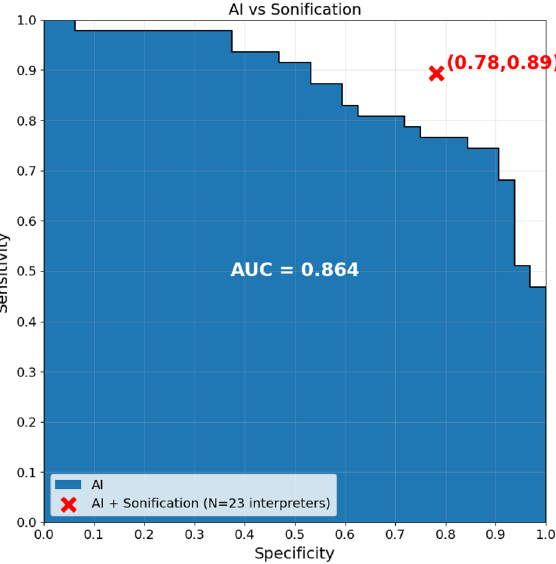
Figure 5. The area under the curve (AUC) for the AI probabilistic output and sensitivity/specificity of the majority vote of the survey participants.